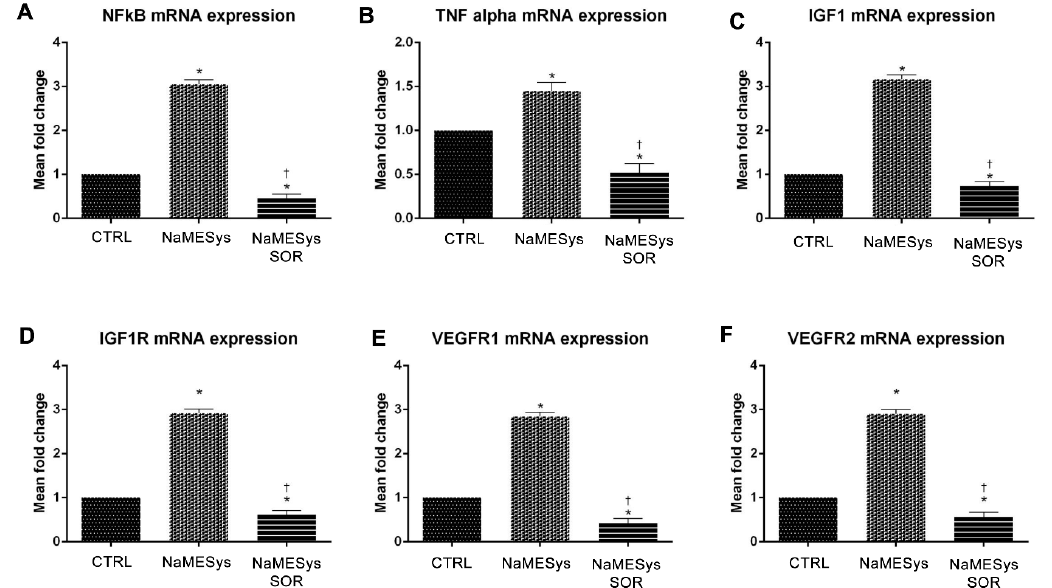
Figure 3. Expression of nuclear factor kappa B (NF κ B), tumor necrosis factor-alpha (TNF α ), insulin like growth factor 1 (IGF1), insulin like growth factor 1 receptor (IGFR1), vascular endothelial growth factor receptor 1 (VEGFR1) and vascular endothelial growth factor receptor 2 (VEGFR2) mRNA levels in retinas of diabetic rats treated with nanostructured micro- emulsions system carrying 0.3% sorafenib (NaMESys-SOR). Quantitative real-time PCR analysis of ( A ) NF κ B, ( B ) TNF α , ( C ) IGF1, ( D ) IGFR1, ( E ) VEGFR1 and ( F ) VEGFR2 expression in retina of non-diabetic control rats treated with vehicle